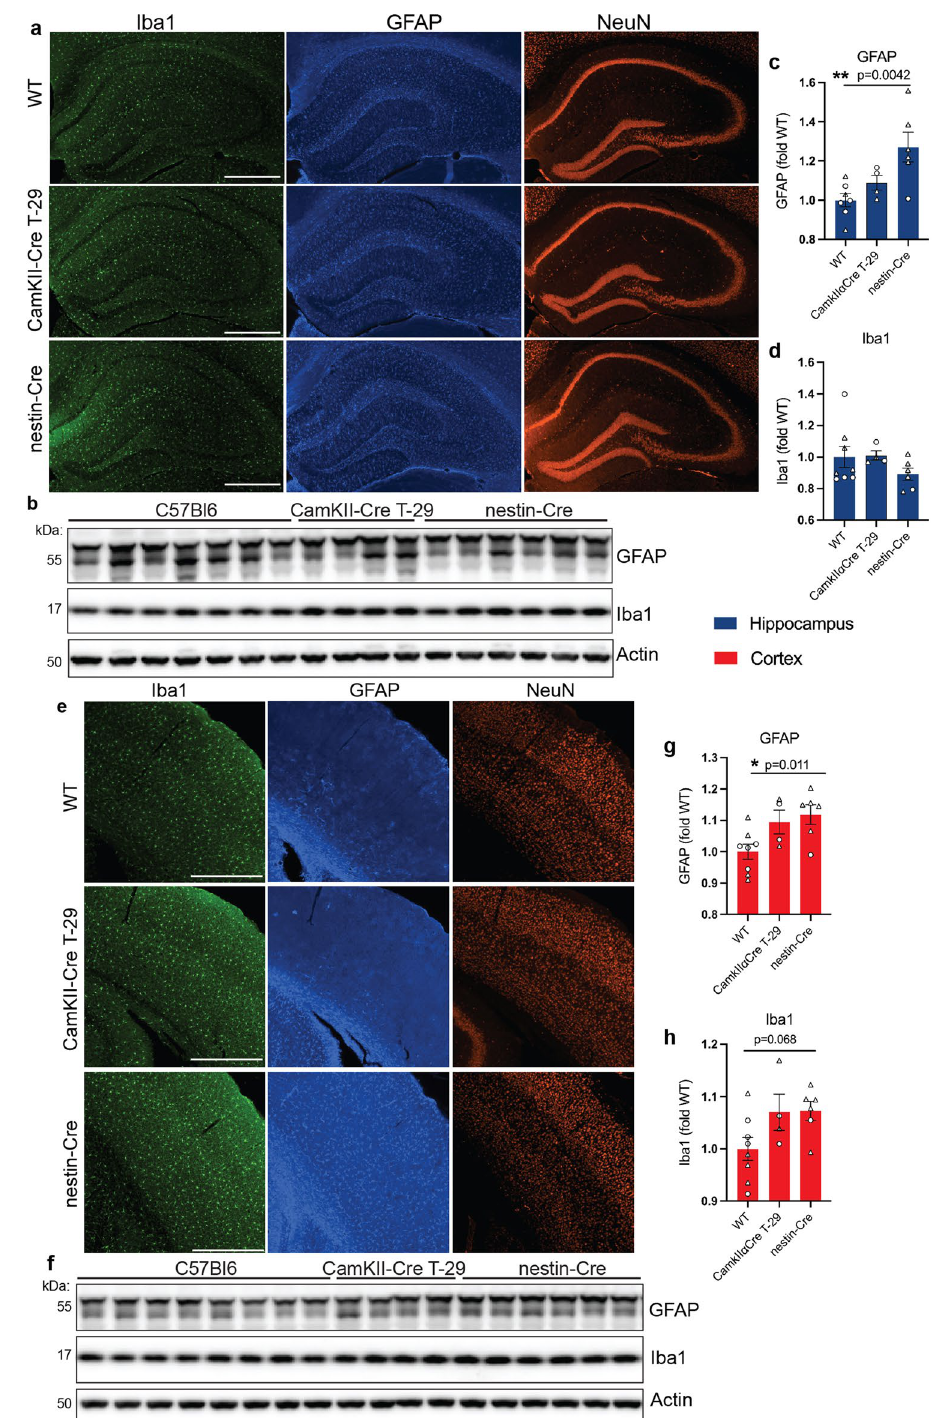
Figure 6. Astrocytosis is increased in hippocampal and cortical brain regions of nestin-Cre mice. (A) Immunofluorescence microscopy of representative coronal brain sections showing the hippocampus from 4-month-old wild-type (WT), CaMKIIα- Cre T29-1 and nestin-Cre mice labeled for Iba1 (green), GFAP (blue) and NeuN (red), scale bars 200 µm. (B) Immunoblot of hippocampal homogenates from 4-month-old WT, CaMKIIα-Cre T29-1 and nestin-Cre mice probed for GFAP, Iba1 and actin. Original immunoblots are shown in Fig. S7A. Quantification of GFAP (C) and Iba1 (D) immunoblots in (B) normalized to actin and expressed as fold of WT (WT, n = 8; CaMKIIα-Cre T29-1 n = 4; nestin-Cre, n = 6). (E) Immunofluorescence microscopy of representative coronal brain sections showing the cortex from 4-month-old WT, CaMKIIα-Cre T29-1 and nestin-Cre mice labeled for Iba1 (green), GFAP (blue) and NeuN (red), scale bars 200 µm. (F) Immunoblot of cortical homogenates from 4-month-old WT, CaMKIIα-Cre T29-1 and nestin-Cre mice probed for GFAP, Iba1 and actin. Original immunoblots are shown in Fig. S7B. Quantification of GFAP (G) and Iba1 (H) immunoblots in (F) normalized to actin and expressed as fold of WT (WT, n = 8; CaMKIIα-Cre T29-1, n = 4; nestin-Cre, n = 6). One-way ANOVA followed by Dunnet’s posttest was performed for all quantifications and values are mean ±